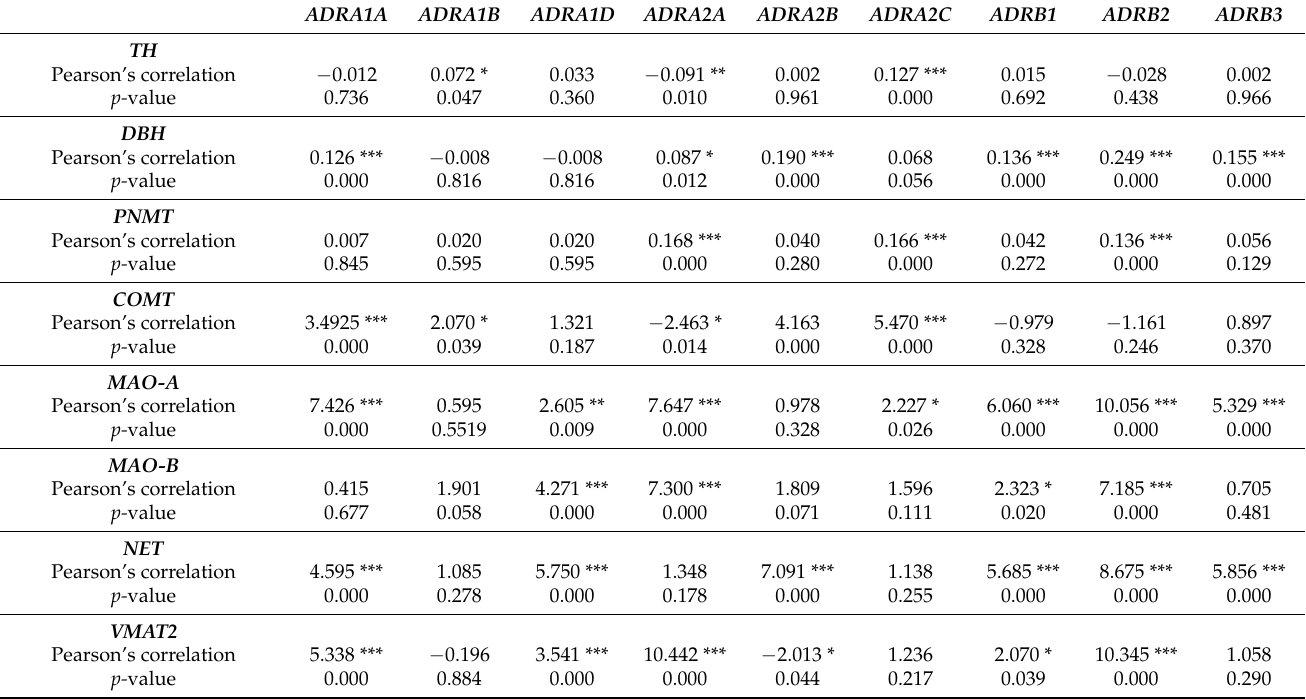
Table 3. Pearson’s correlation between the gene expression of ADRs and markers of catecholamine metabolism in the BC tissues (dataset obtained from TCGA